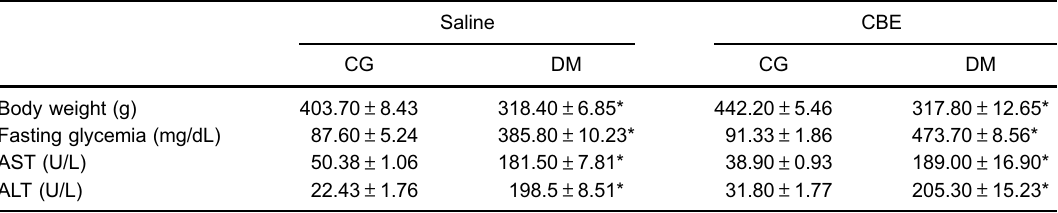
Table 1. Body weight, fasting glycemia, and plasma markers of hepatic injury of Wistar rats after 14 days of oral administration of chlorophyll-based extract (CBE; 22 mg/L) or saline. Saline